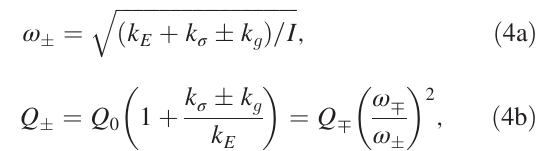
FIG. 4. Torsion micropendulum gravimeter. (a) Device geom- etry: a Si 3 N 4 nanoribbon (blue) loaded with a Si pad (gray). (b) Photographs, (c) displacement spectra, and (d) ringdowns of the device in inverted and noninverted configuration. (e) Free- running (green), driven (red), and temperature-corrected (blue) Allan deviation measurements. Inset: frequency (red) and temper- ature (blue) of driven device. Dashed lines: thermal noise (green) and drift (red)